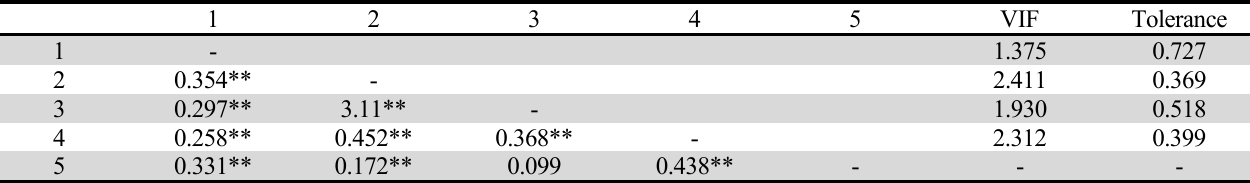
Pearson’s correlation coefficients and multicollinearity